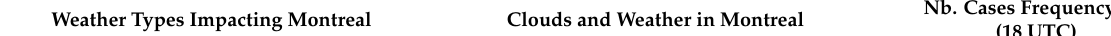
Table A1. Description of synoptic meteorology classes (i.e., weather type) over Montreal with its impact on clouds and weather. The last column indicates the number of cases and frequency of each type during spring periods of years 2006–2008 (observed at 18 UTC, i.e.,